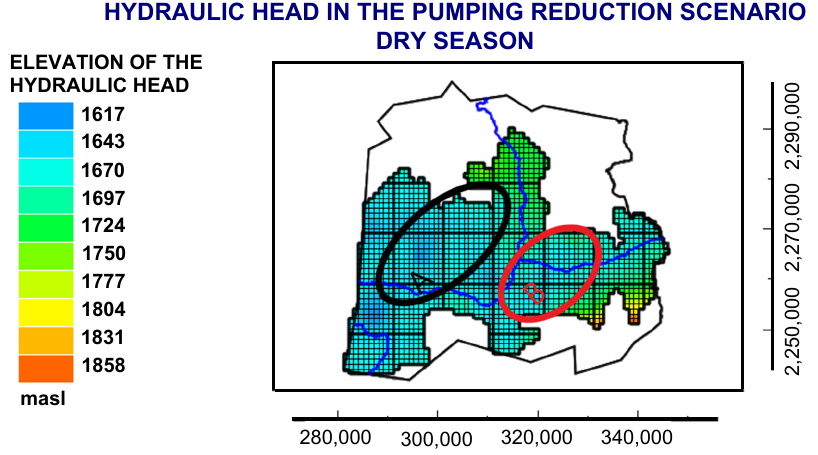
Figure 22. Elevation of the hydraulic head of the year 2030 through the pumping reduction scenario Figura 3.11: Elevaci´on de la carga hidr´aulica del a˜no 2030 a trav´es del escenario Reducci´on de in the dry season. Bombeo en la Temporada de Secas.